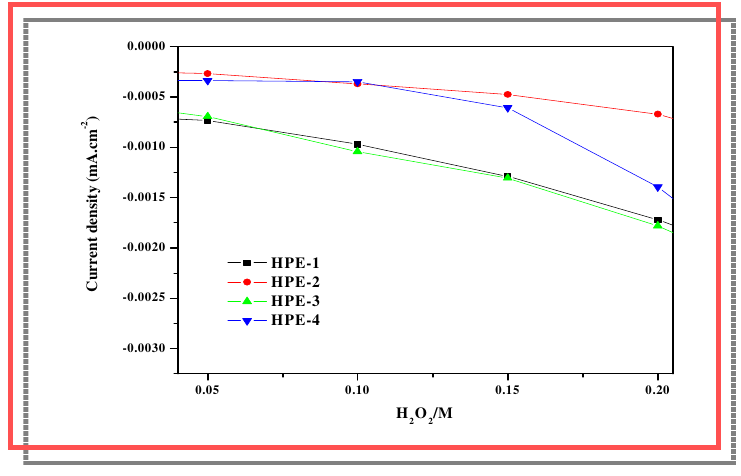
Figure 6. Current density-concentration of hydrogen peroxide curves for the enzyme